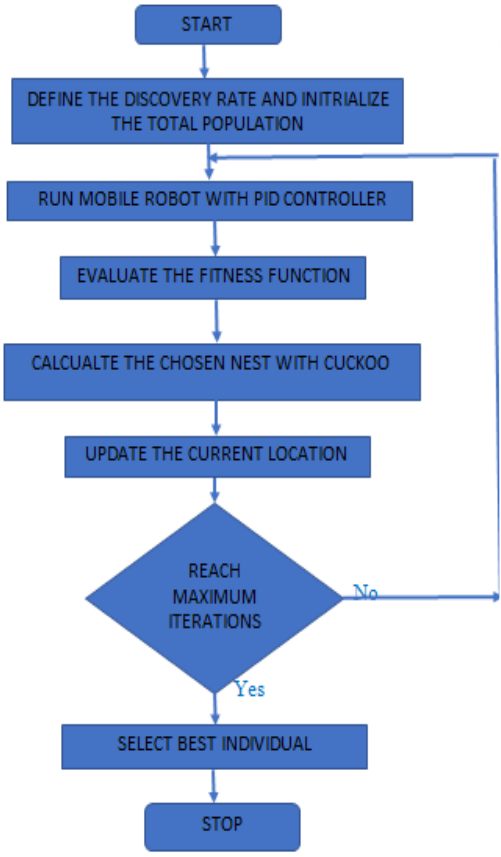
Figure 6. Flow Chart of CSO algorithm.